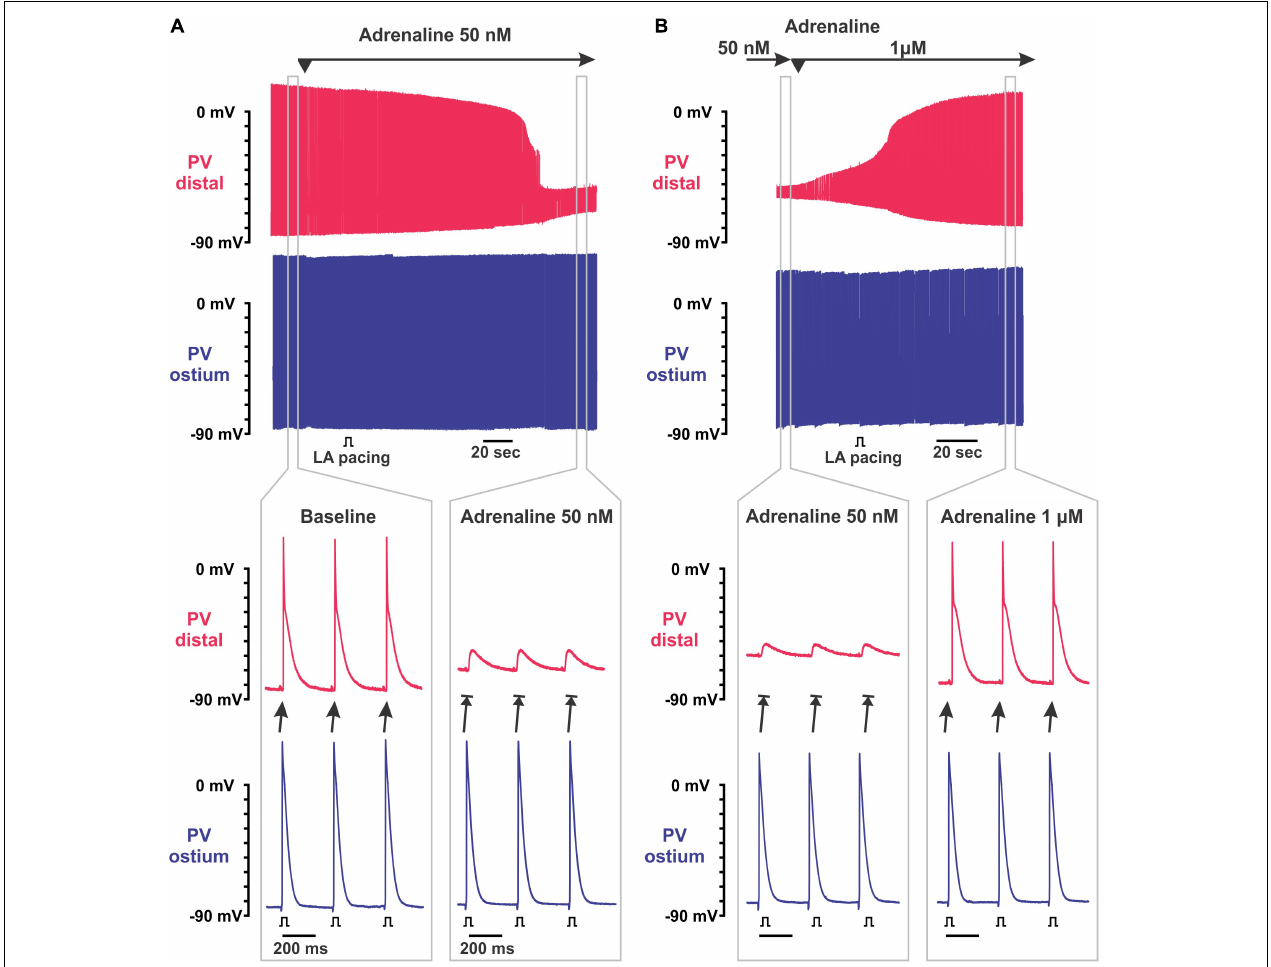
FIGURE 2 | Biphasic effect of adrenaline on intra-pulmonary vein (PV) conduction. (A) Application of 50 nmol/L adrenaline results in the depolarization of resting membrane potential (RP) exclusively in PV dis leading to intra-PV conduction dissociation. Two simultaneous microelectrode recordings from PV dis (top recording in red) and PV ost (bottom recording in blue) are shown. Below, selected time windows (gray rectangles) are shown enlarged before (baseline) and during PV dis inexcitability under 50 nmol/L adrenaline. Left atria (LA) was constantly paced with S1S1 = 300 ms. (B) Application of 1 µ mol/L adrenaline recovered intra-PV conduction suppressed by 50 nmol/L adrenaline. Below, selected time windows (gray rectangles) are shown enlarged before and after the recovery of excitability of PV dis